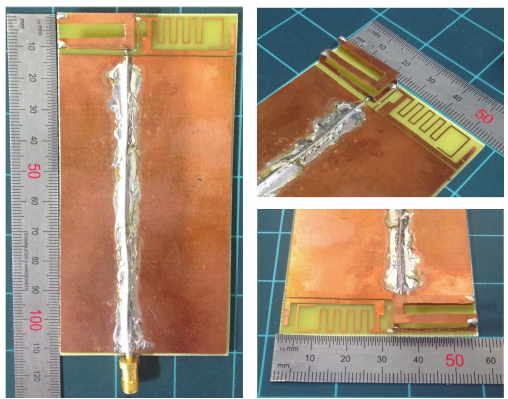
Figure 9: Simulated and measured return loss characteristics of the proposed